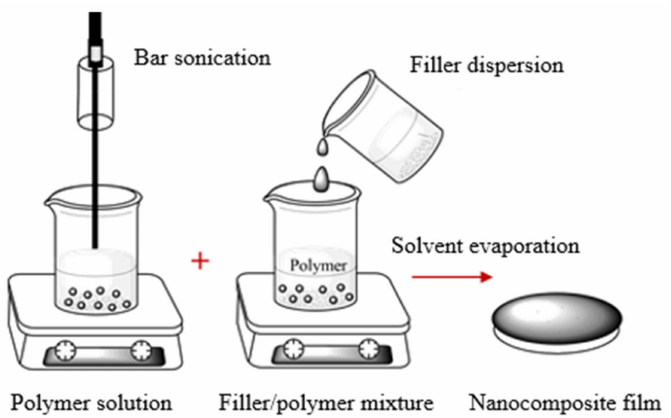
Figure 3. Schematic representation of solution/emulsion processing method.